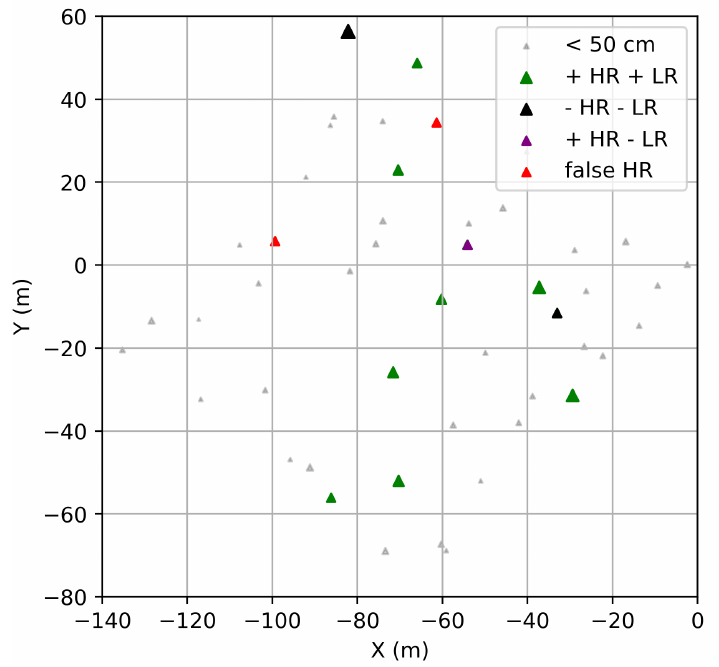
Figure 8. Locations of the mounds derived from the 1 ha benchmark data set. + (plus) means the mound is detected; − (minus) means it is not detected by the UAV-LS detection algorithm. The grey mounds are small mounds < 50 cm that could only be detected in the benchmark data set.